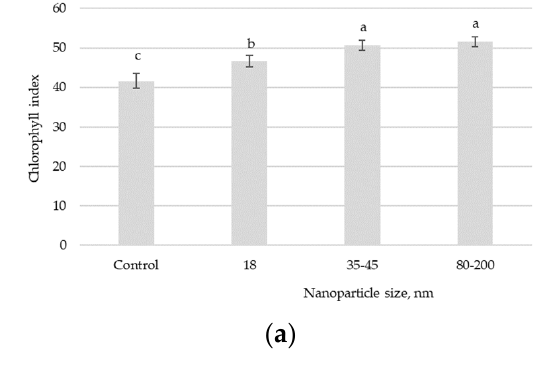
Figure 1. Particle size-dependent effects of ZnO nanoparticles on chlorophyll ( a ) and flavonol ( b ) indexes in Swiss chard. Different letters represent significant differences. The data were processed using analysis of variance (ANOVA) and the Tukey (HSD) multiple range test at the confidence level p = 0.05.